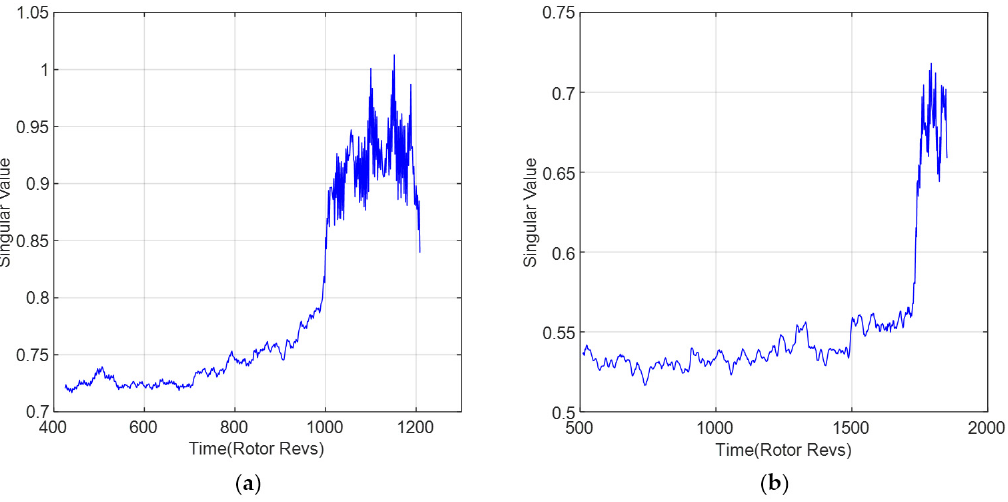
Figure 5. Variation of singular value in sliding window: ( a ) Singular value at 2500 rpm; ( b ) Singular value at 3000